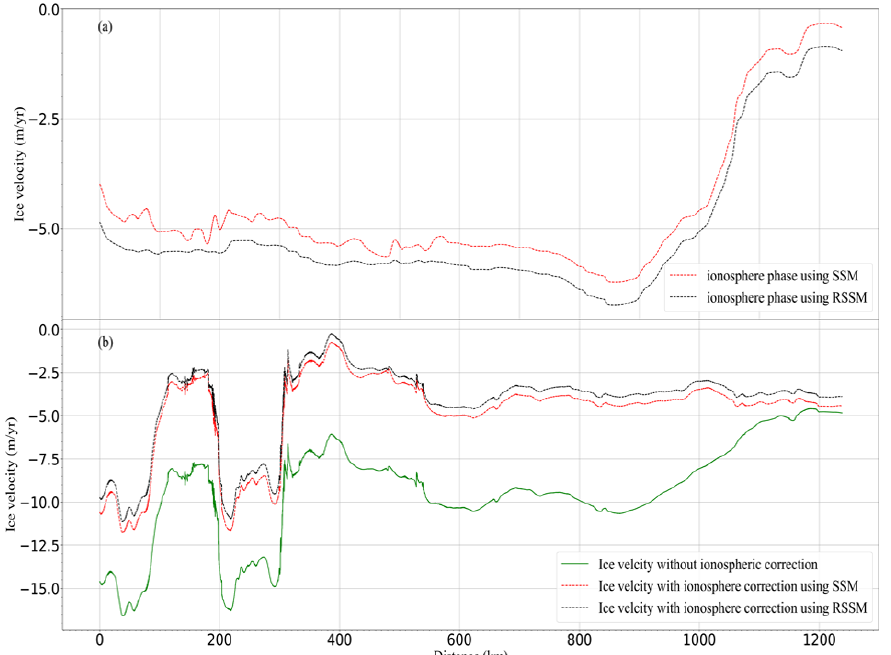
Figure 5. ALOS PALSAR images’ ionospheric correction results. ( a ) Interferogram without iono- spheric correction. ( b ) Interferogram with ionospheric correction using SSM. ( c ) Interferogram with ionospheric correction using RSSM. We can distinguish phases related to ice motion and the iono- sphere from Figure 5a,b.